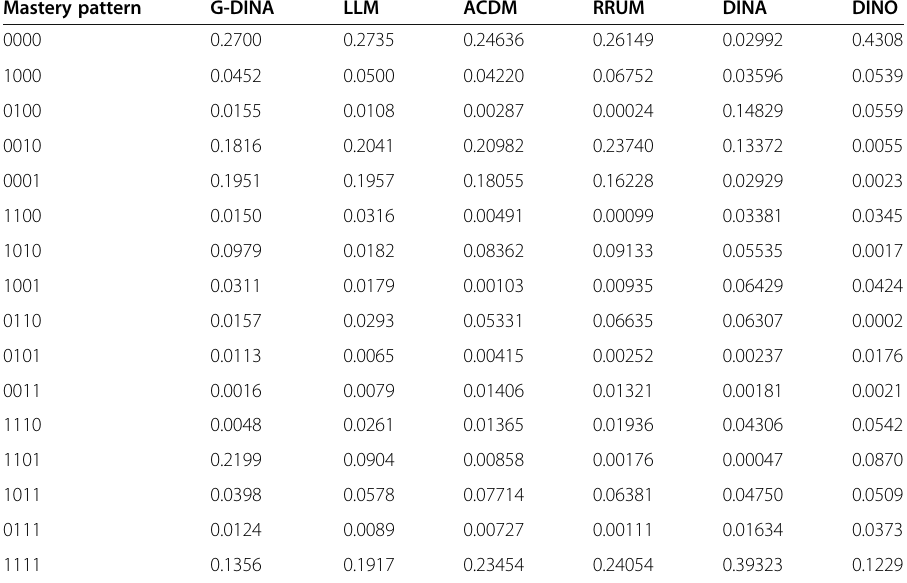
Table 5 Proportion of skill mastery profiles Mastery